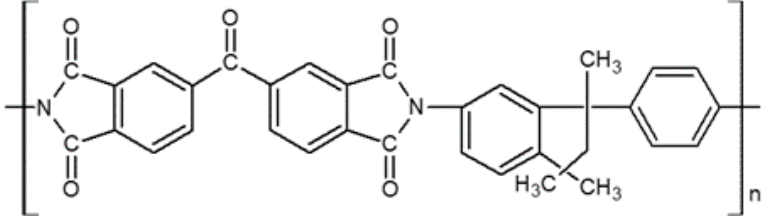
Figure 6. Chemical structure of the Matrimid polyimide precursor.